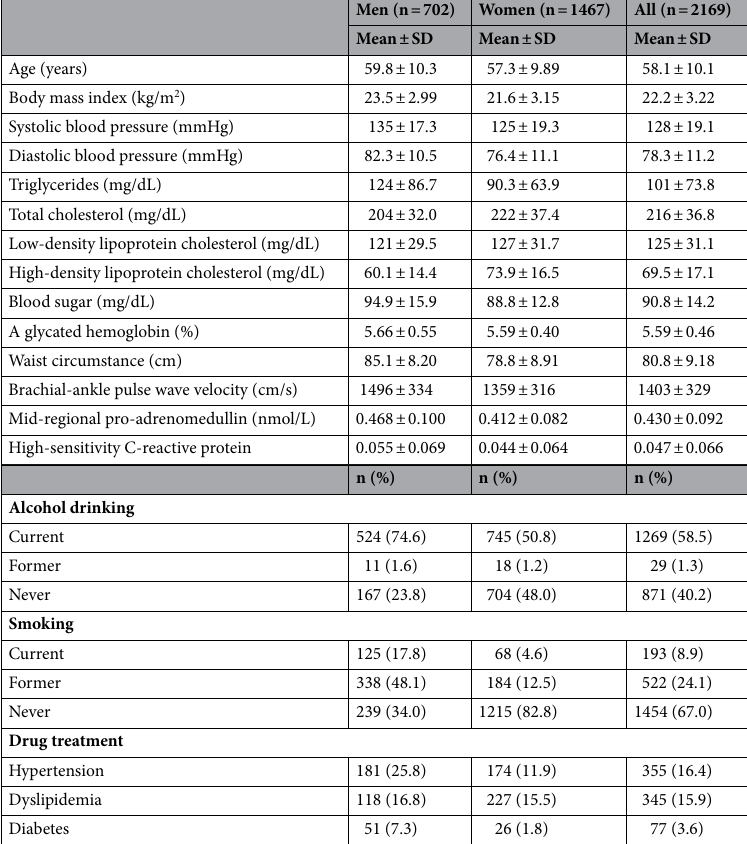
Table 1. Participant characteristics at baseline according to sex.